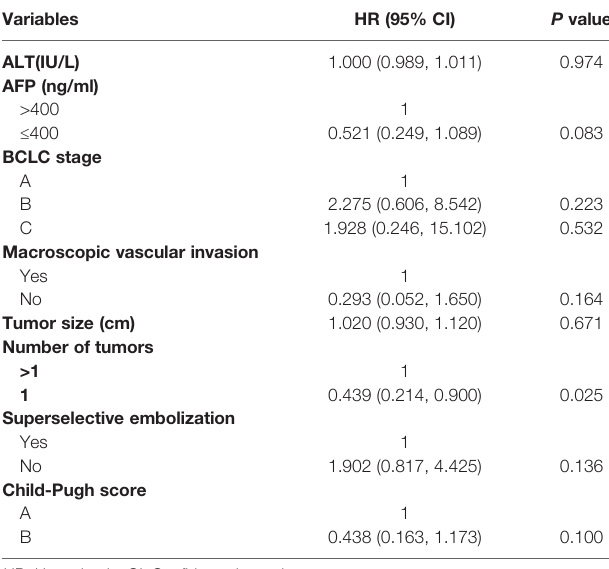
TABLE 4 | Multivariate analysis of prognostic factors for progression-free survival. (PFS).